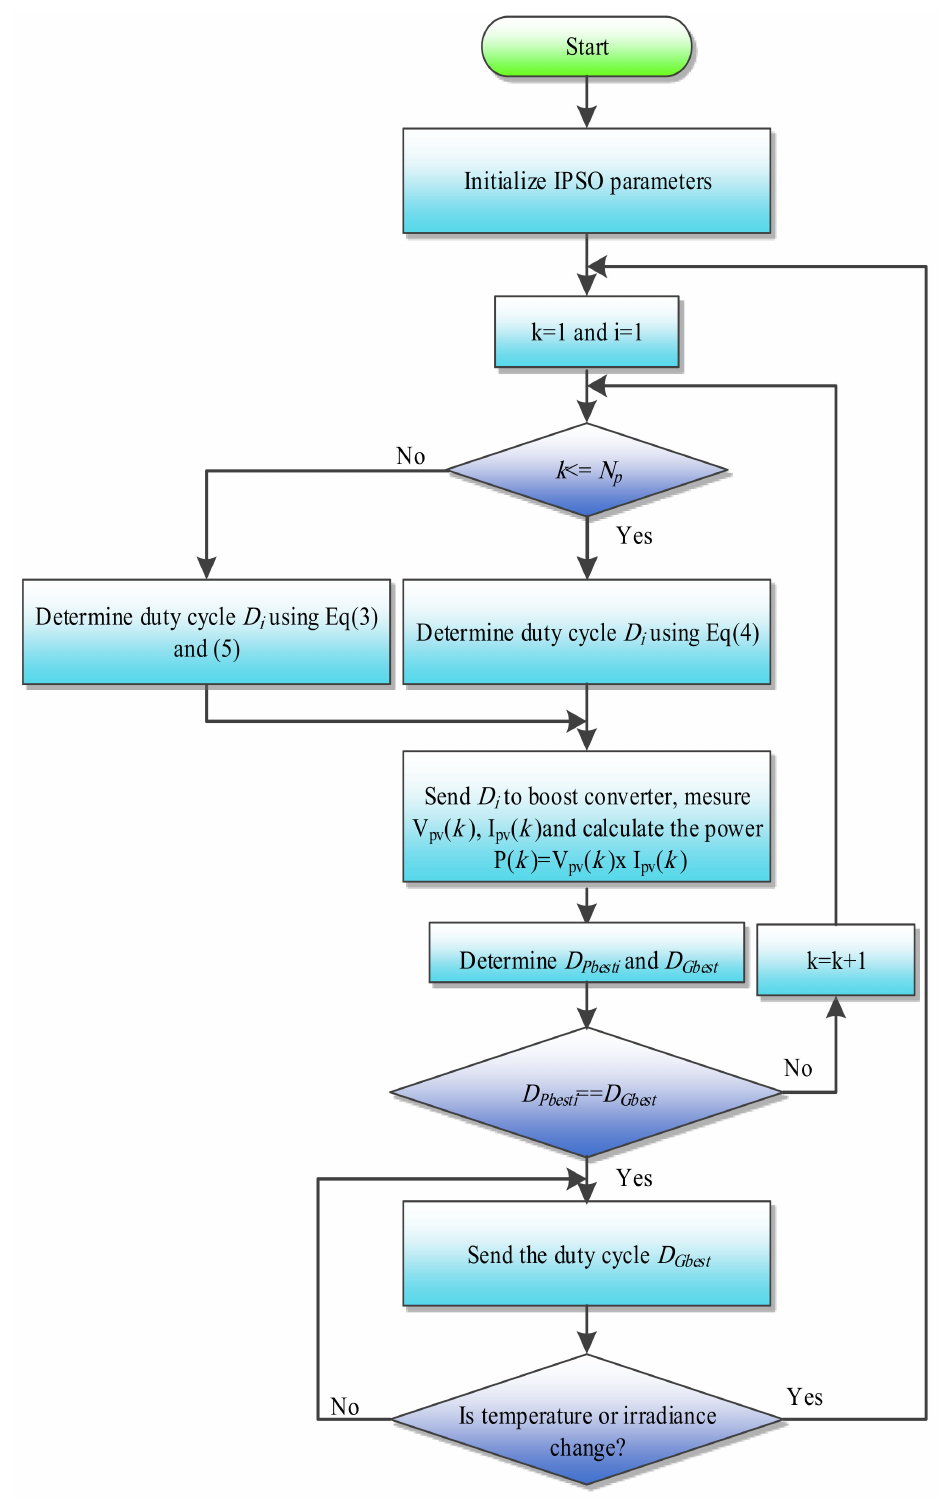
Figure 4. Flowchart of the IPSO-based MPPT